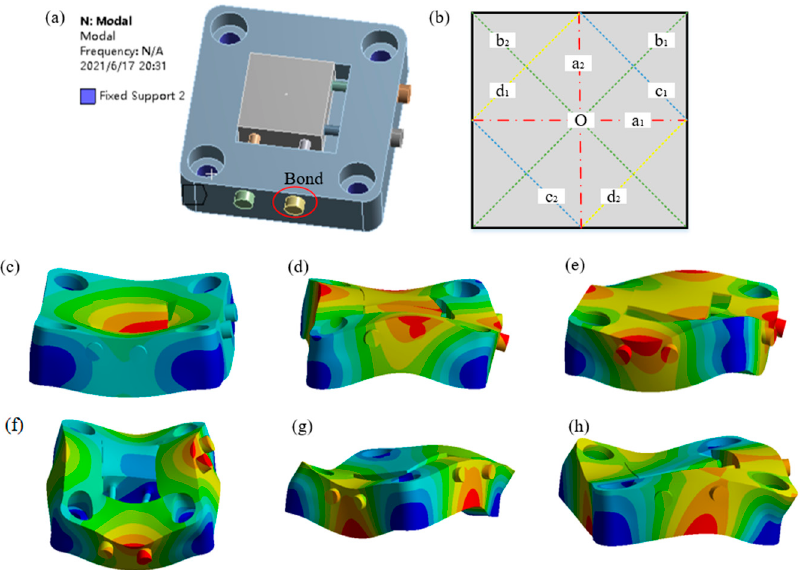
Figure 7. Mode analysis of the workpiece fixture. ( a ) Constraint; ( b ) Schematic diagram of indicator line; ( c − h ) Mode 1 − 6. Table 1. The natural frequencies of the first six-order mode.